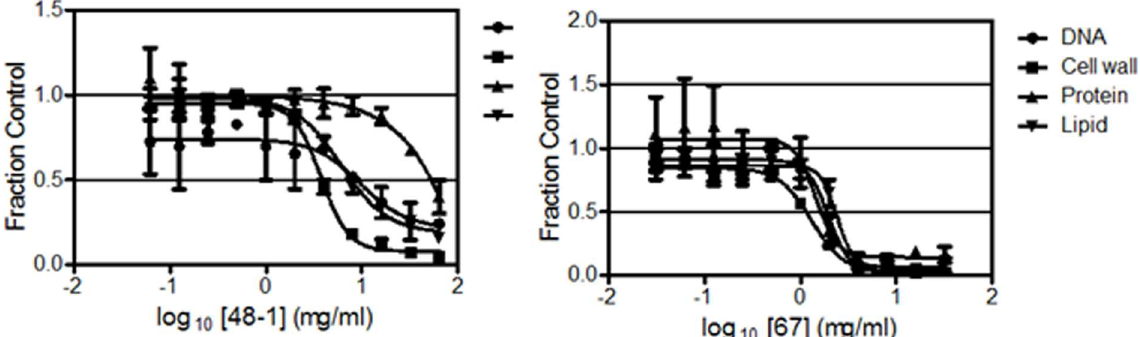
Fig 2. MMS analysis of 6jc48-1. The effects of 6jc48-1 (MIC 4 μ g/ml) and Jc-67 (BAS00127538)(MIC 2 μ g/ml) on the macromolecular synthetic pathways for DNA, Cell wall, protein, and lipid.